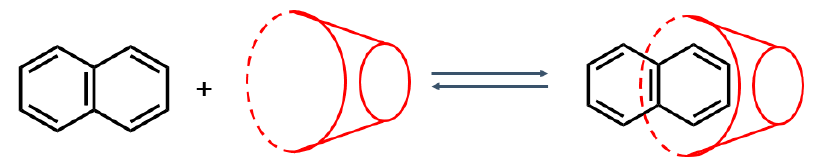
Figure 1. Cyclodextrin and naphthalene have host–guest